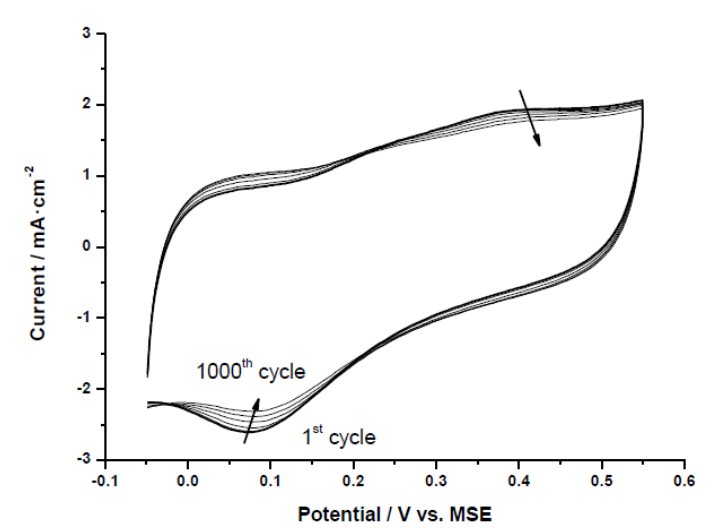
Figure 6. Accelerated Pt degradation test by potential cycling for Pt/CX-4-RC-50-Ac, 1000 cycles in 0.5 M H SO at room temperature. 2 4